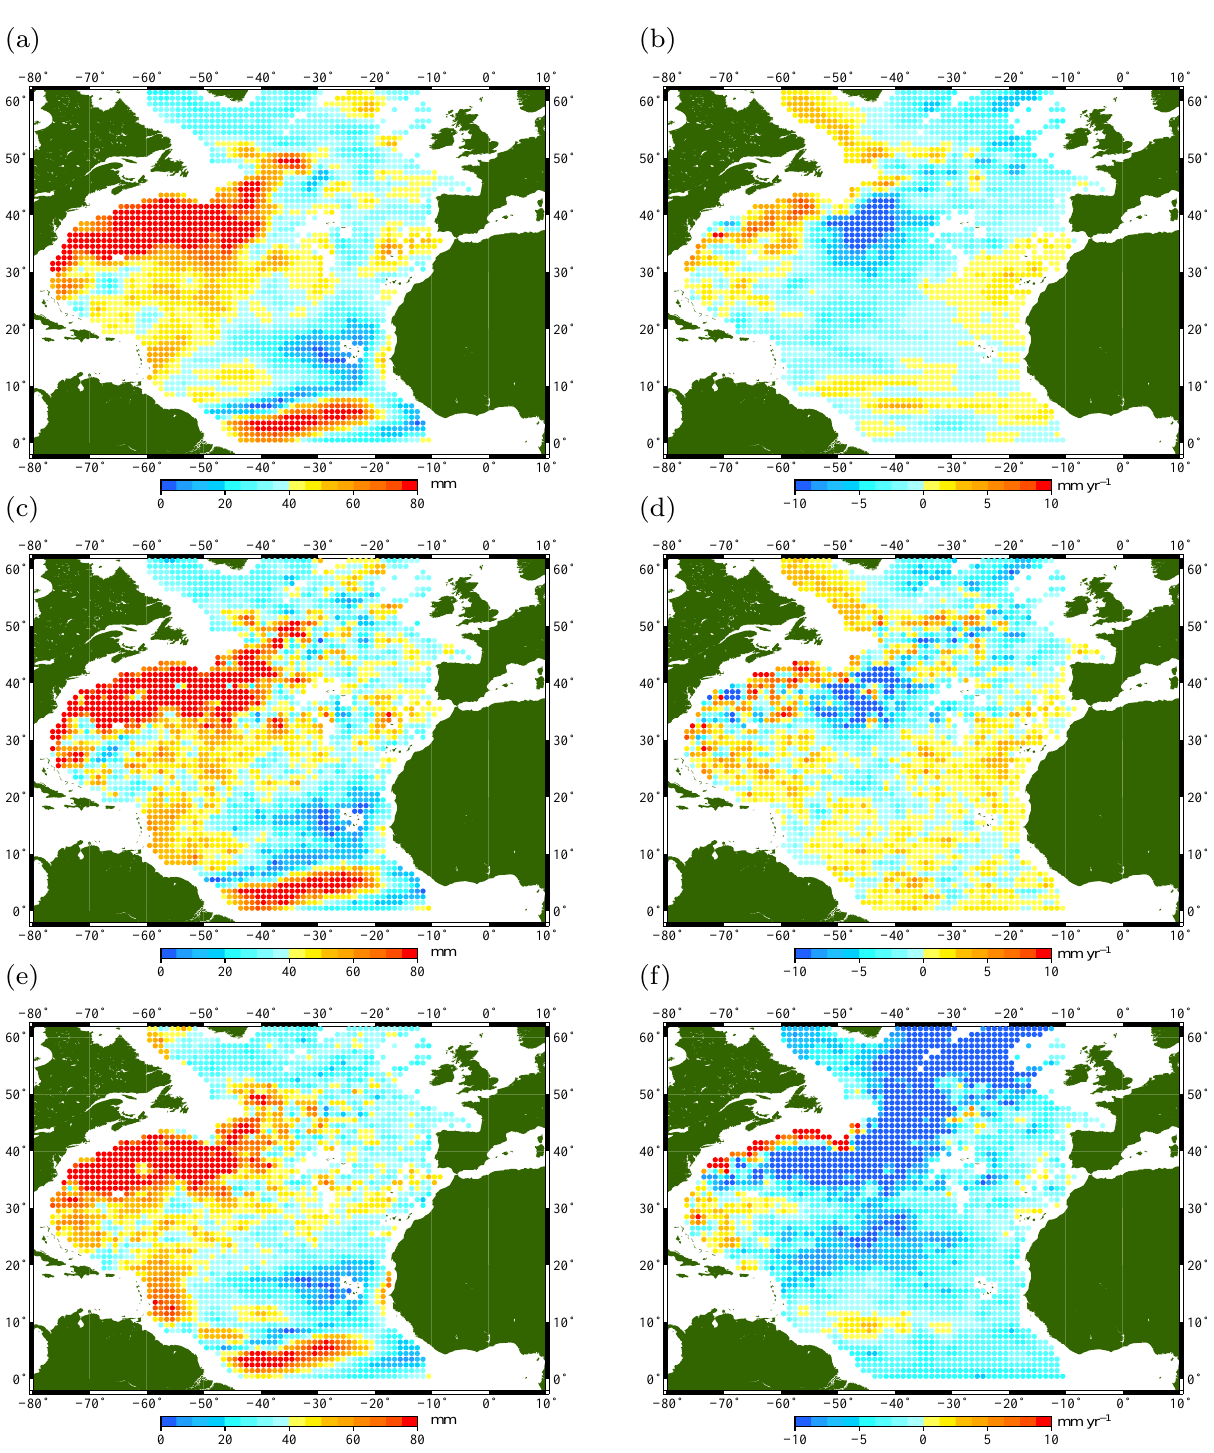
Figure 5. Amplitudes of the annual signal (left) and trends (right) computed with the Scripps grids (a, b) , the method in this study (c, d) and from the Glorys reanalysis product (e, f)